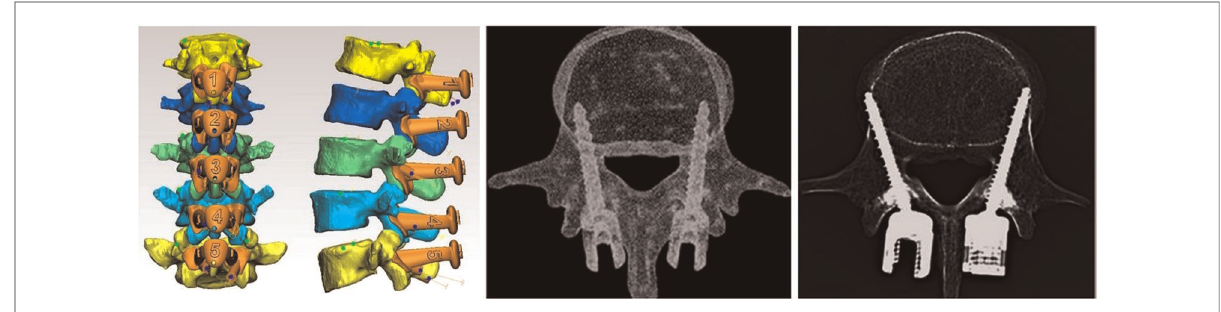
FIGURE 2 Difference between the traditional CBT and modi fi ed CBT technique, and the shape design of the 3D-navigation-template matched with different vertebra (middle picture reference: (25). To make up for the de fi ciency and further increase the strength of screw placement, we altered and modi fi ed the insertion point and track of CBT. Without changing the horizontal axis, the vertical axis of the insertion point of the cortical bone screw was moved from the conventional mid-perpendicular line of the articular process to the tangent line of the median wall of the pedicle